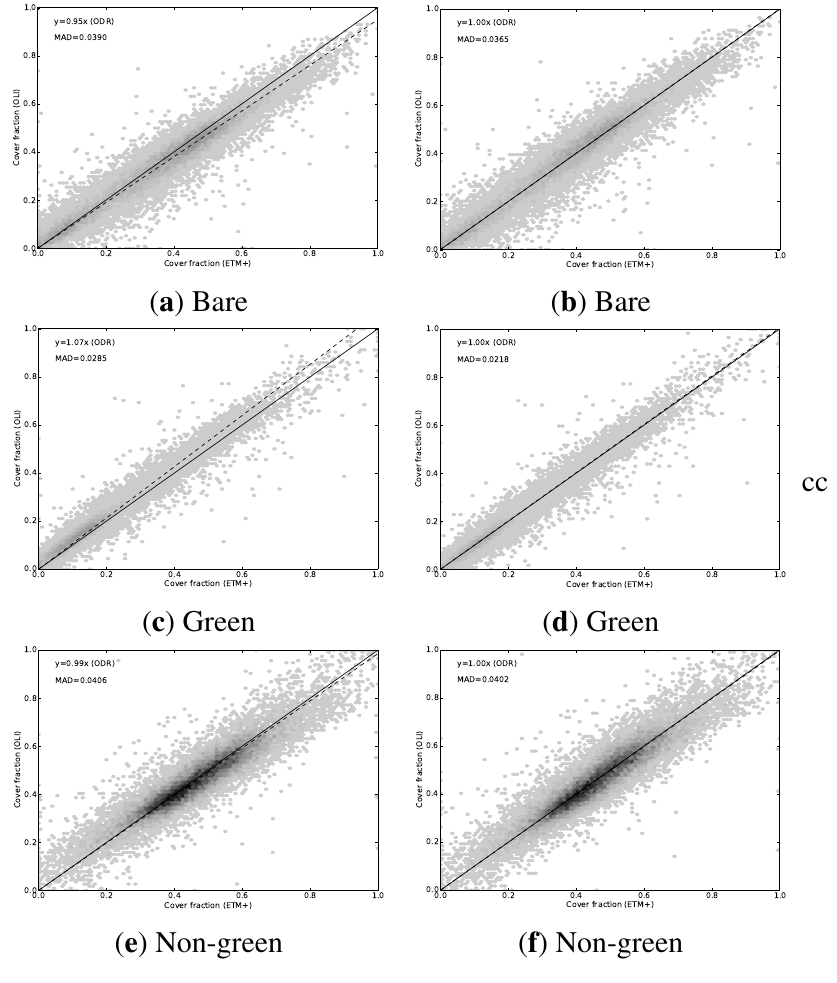
Figure 6. Fractional vegetation cover for Landsat-7 and Landsat-8. ( Left panel ) Cover fractions using unadjusted surface reflectance as input; ( Right panel ) Cover fractions using OLI surface reflectance adjusted by fitted regression to match ETM+. ( a , b ) Bare, ( c , d ) Green, ( e , f ) Non-green. Solid line is the one-to-one line, dashed line is the ODR